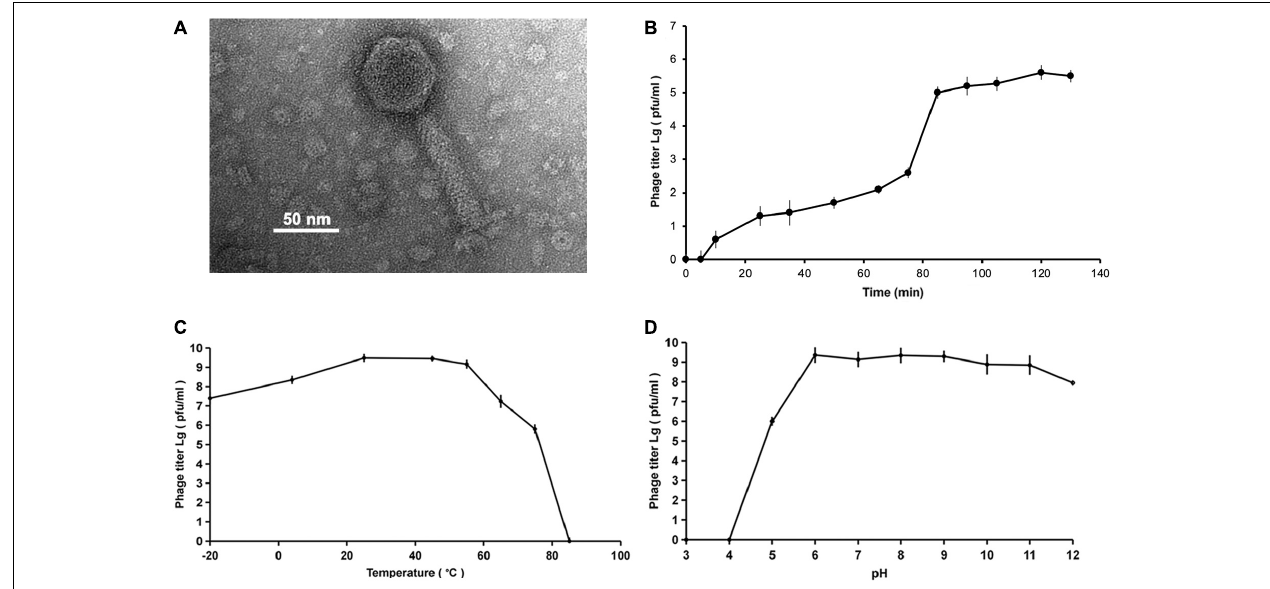
FIGURE 1 | (A) Transmission electron microscopy (TEM) of bacteriophage vB_MalS-PS3. The scale bar is 50 nm. (B) One-step growth curve of vB_MalS-PS3. (C) The curve of thermal stability of vB_MalS-PS3. (D) The curve of capsid stability of vB_MalS-PS3. The Y -axis of the figure is a log scale.